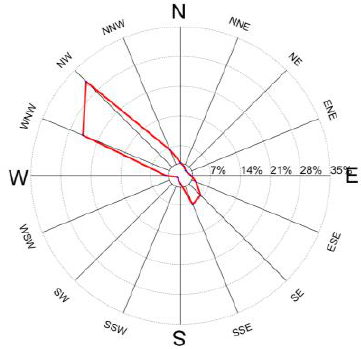
Figure 4. Wind direction rose diagram at 30 m from the 3D Doppler radar.